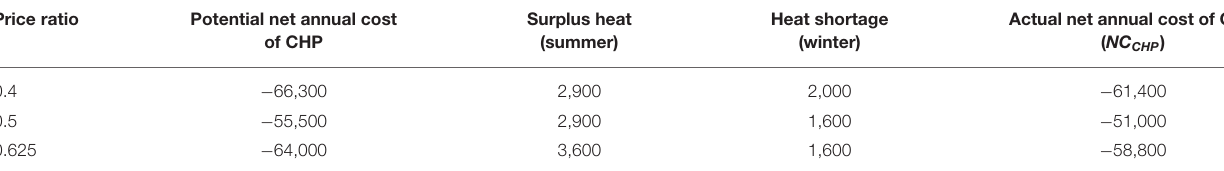
TABLE 6 | Net annual cost ( e /year) of CHP.